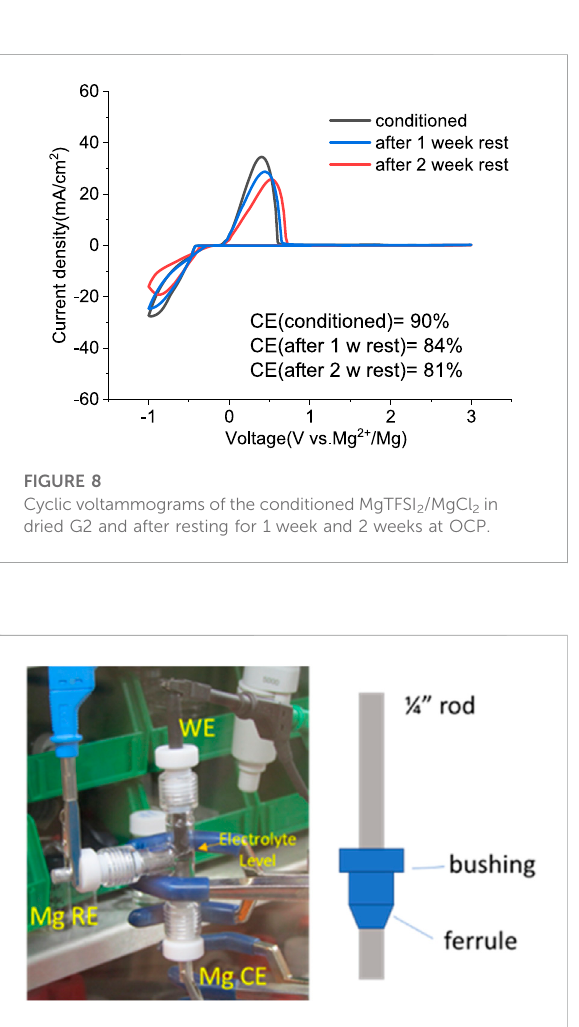
FIGURE 9 Photograph of an assembled three-electrode cell in the glovebox. It is mounted in a standard three-prong lab